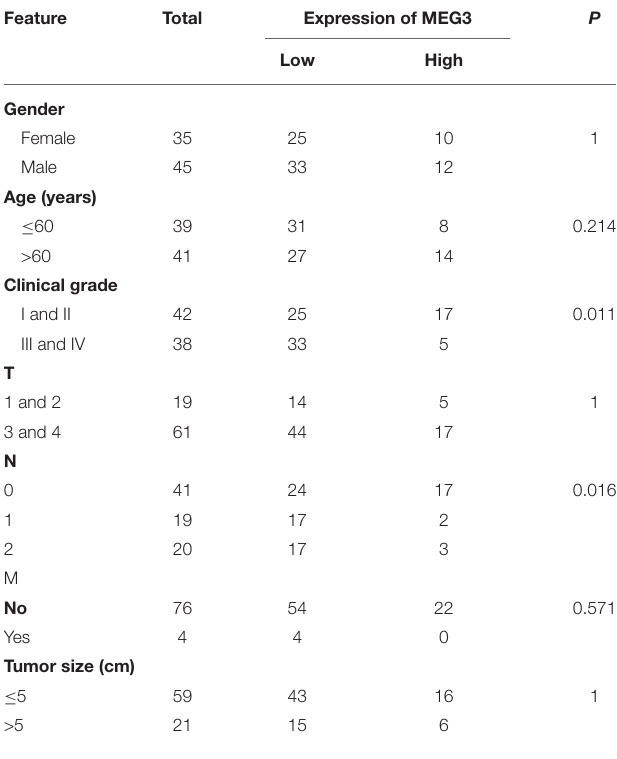
TABLE 1 | Association of maternally expressed gene 3 ( MEG3 ) expression with clinicopathological variables in patients with colorectal cancer (CRC) ( n = 80).